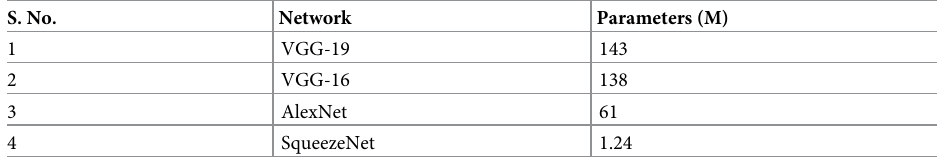
Table 1. Parameters overview of different CNN architectures.